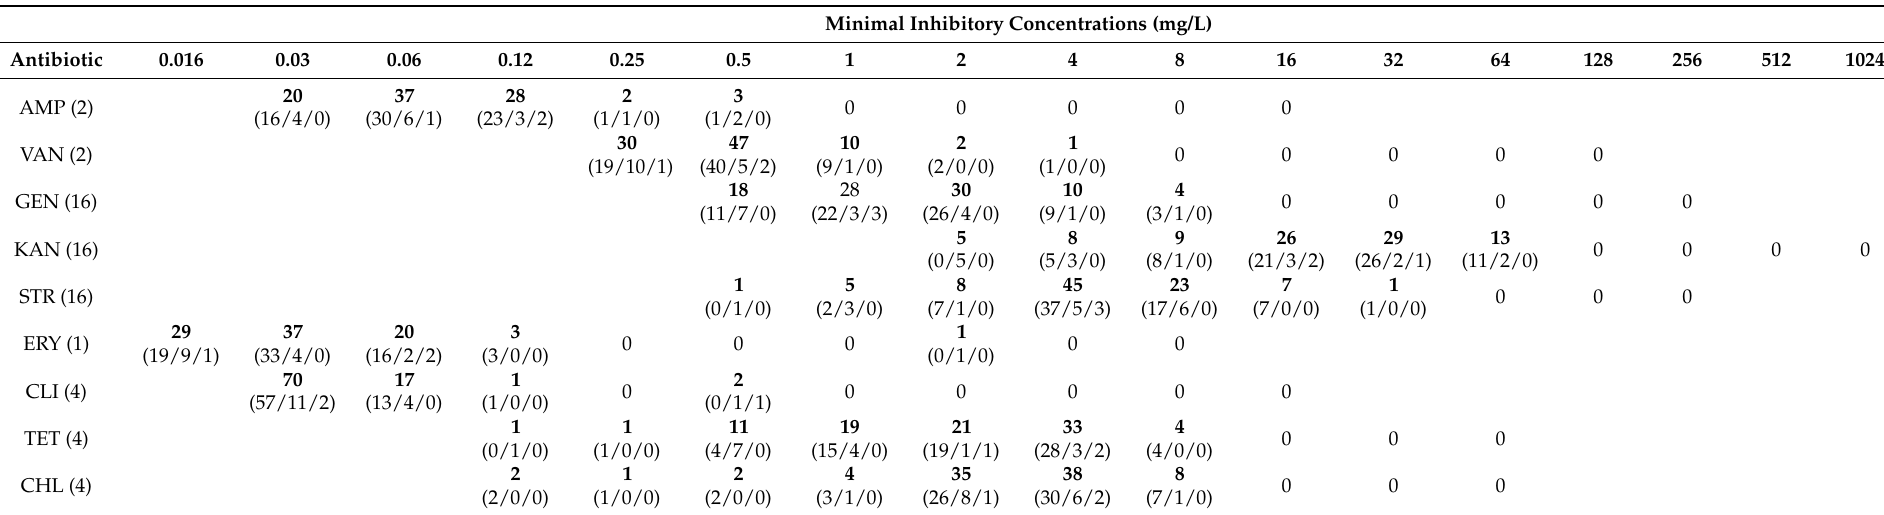
Table 3. Distributions of the minimal inhibitory concentrations of the analyzed strains. The bolded numbers indicate the number of strains for all subspecies analyzed ( Lactobacillus delbrueckii subsp. lactis , bulgaricus and sunkii ). The numbers of strains for each subspecies are indicated in brackets in this order: lactis , bulgaricus , sunkii . The microbiological cutoffs proposed by the European Food Safety Authority are indicated in brackets beside each antibiotic and expressed in mg/L. AMP: ampicillin; VAN: vancomycin; GEN: gentamycin; KAN: kanamycin; STR: streptomycin; ERY: erythromycin; CLI: clindamycin; TET: tetracycline; CHL: